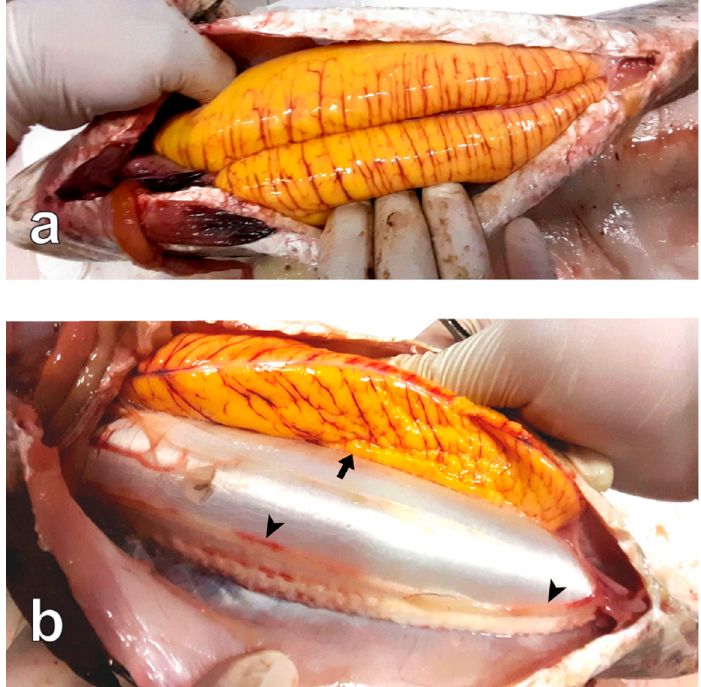
Figure 3. Meagre females sampled on 9 July 2021. ( a ) Specimen showing well developed ovaries. ( b ) Specimen showing a well ‐ developed ovary (arrow) and an undeveloped ovary (arrowhead).